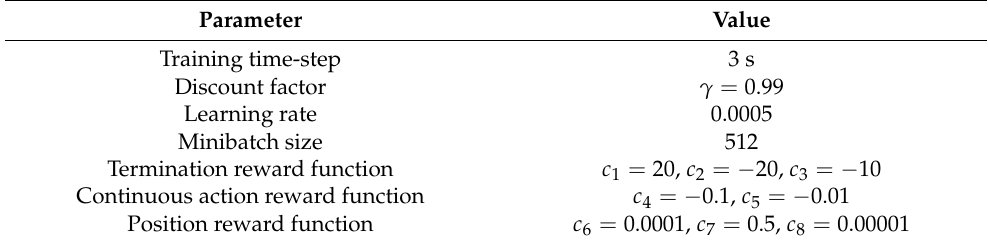
Table 2. Deep reinforcement learning parameters.